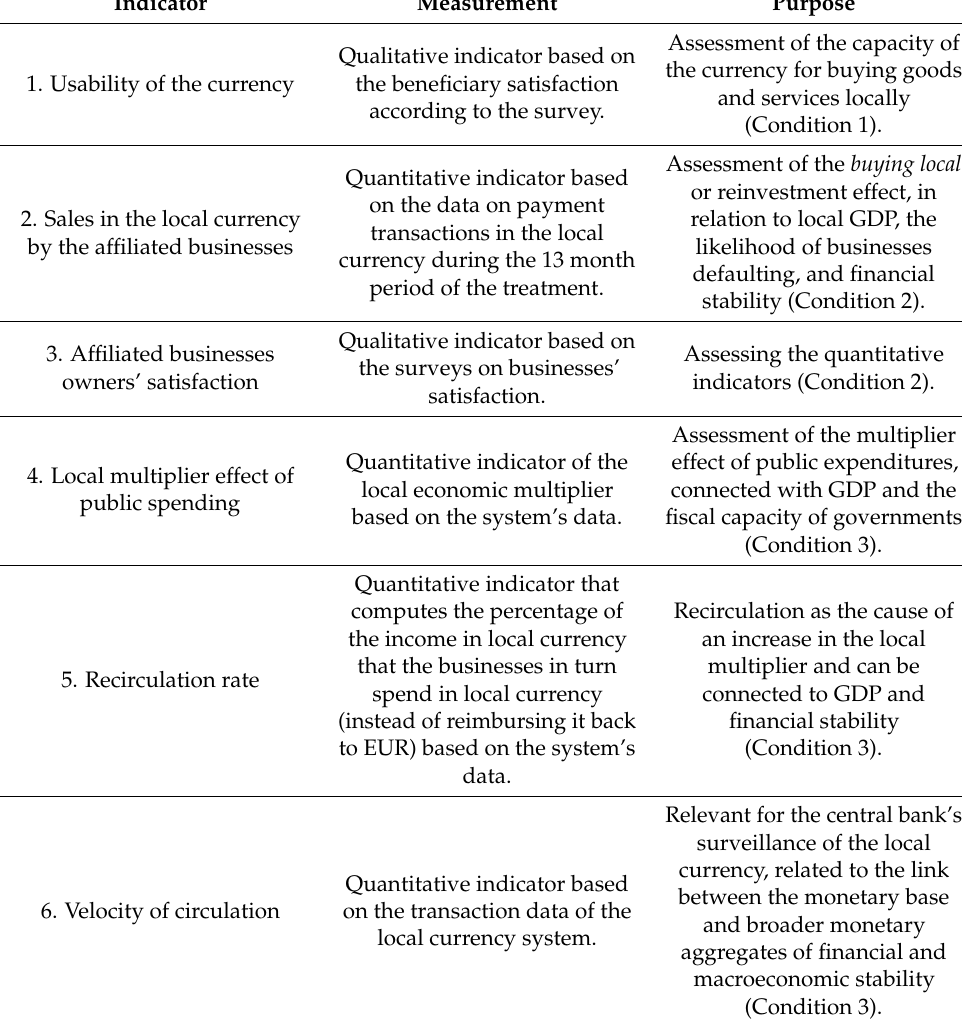
Table 1. Summary of